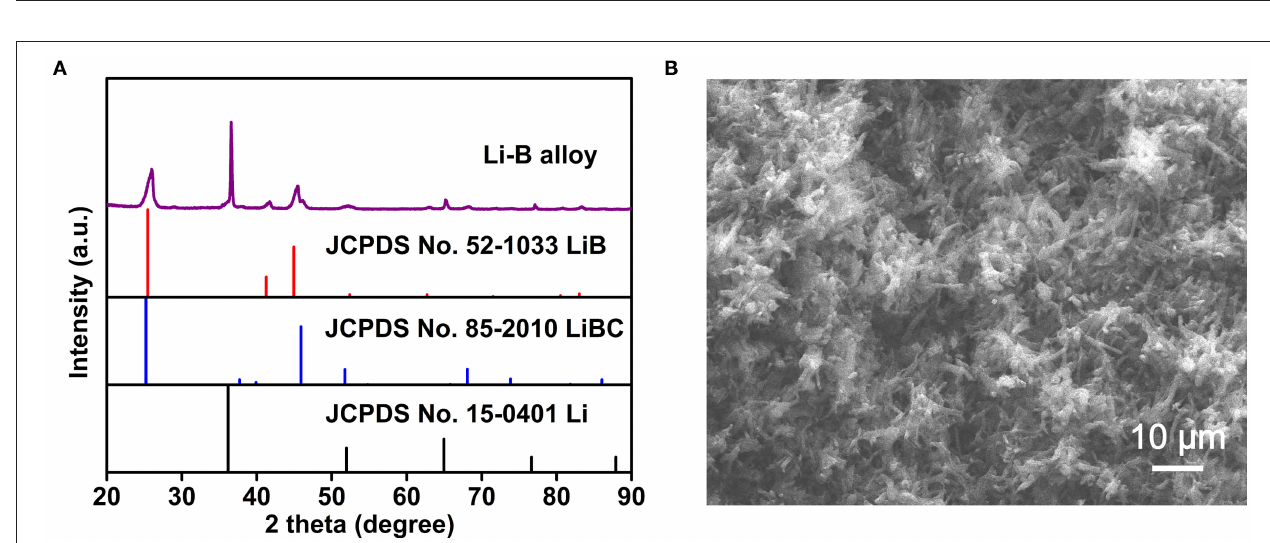
FIGURE 2 | (A) The XRD pattern for the Li-B alloy. (B) The SEM image for the Li-B alloy after Li dissolution.